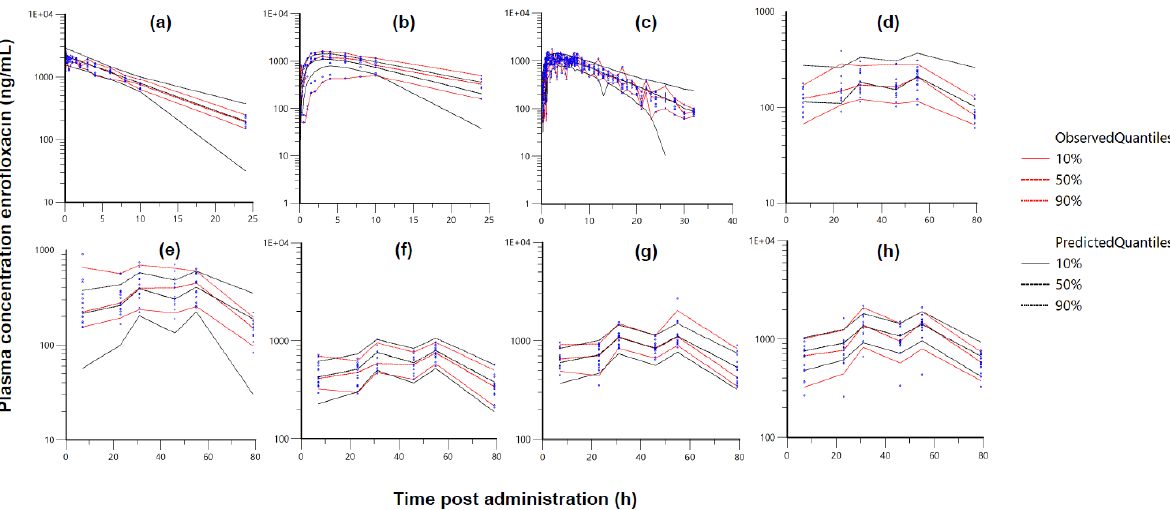
Figure 2. Stratified visual predictive check (VPC) of the different treatment groups (( a )—IV, ( b )—PO richly sampled, ( c )—PO sparsely sampled, ( d )—drinking water administration 2.5 mg/kg, ( e )—drinking water administration 5 mg/kg, ( f )—drinking water administration 10 mg/kg, ( g )—drinking water administration 15 mg/kg, and ( h )—drinking water administration 20 mg/kg) with 200 replicates of each animal. Approximately 20% of the data should fall outside the plotted quantiles. Red lines: observed quantiles; black lines: predicted quantiles; blue circles: observed data. There was good correlation (Figure 3) between the observed water consumption and the water consumption estimated by the model (R 2 = 0.802).